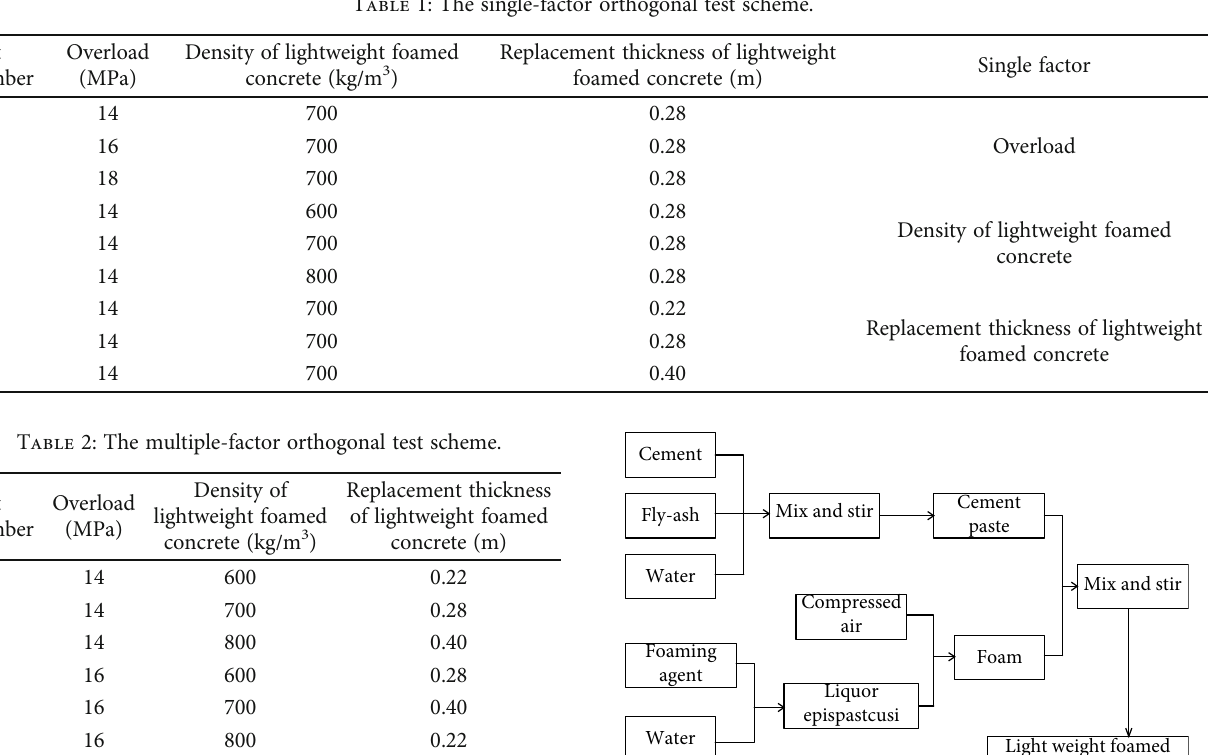
Table 1: The single-factor orthogonal test scheme.